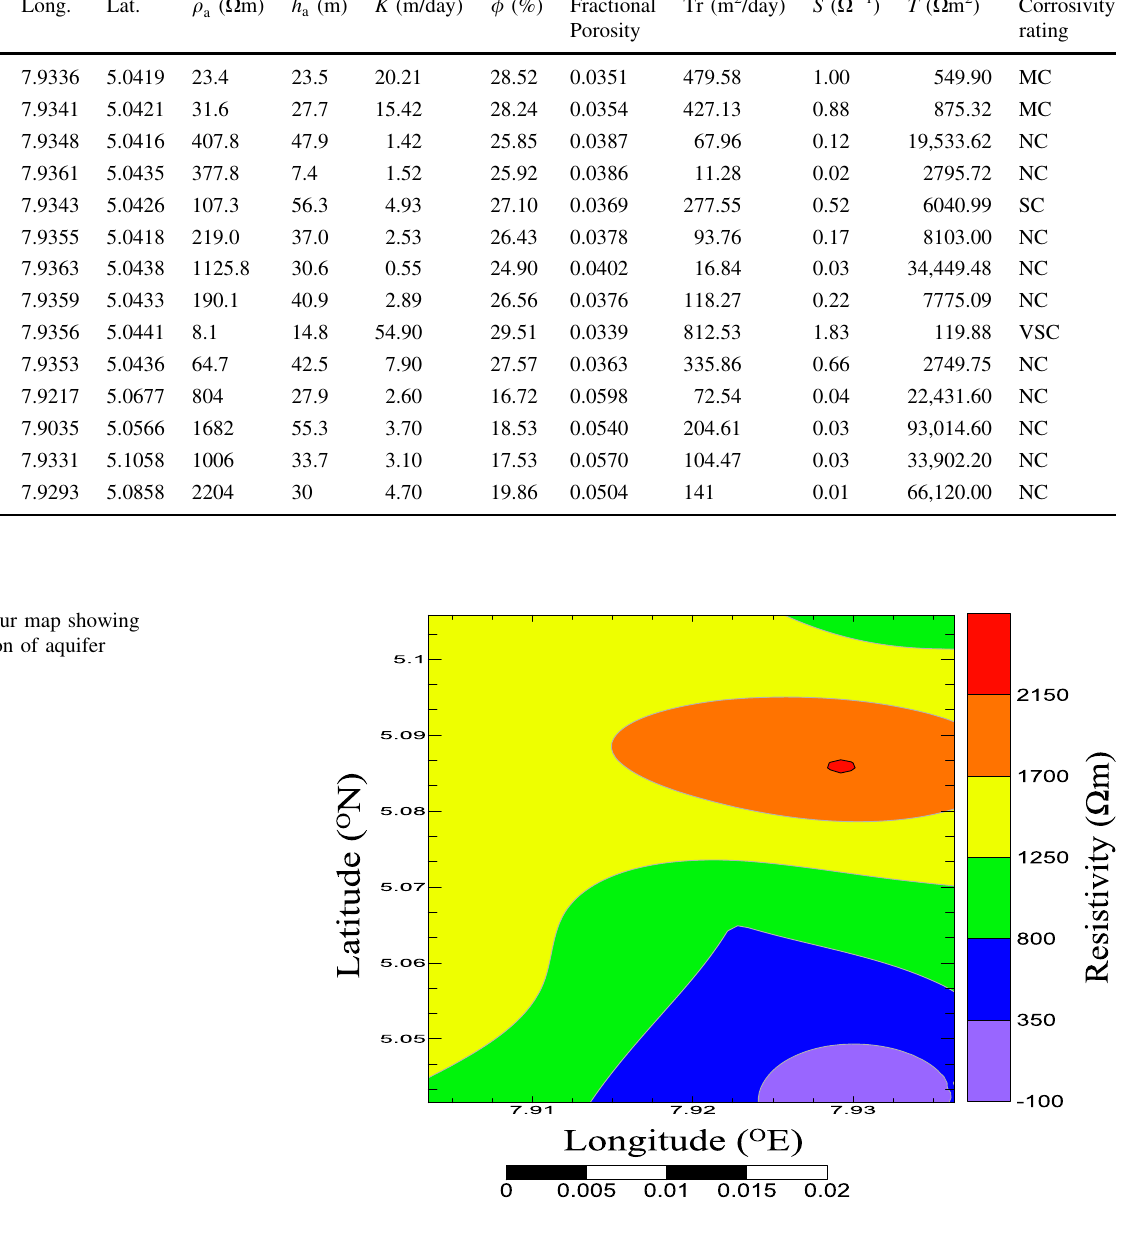
Table 2 Results of aquifer hydraulic parameters from measured resistivity and thickness of the aquifer layers VES stations Long. Lat.